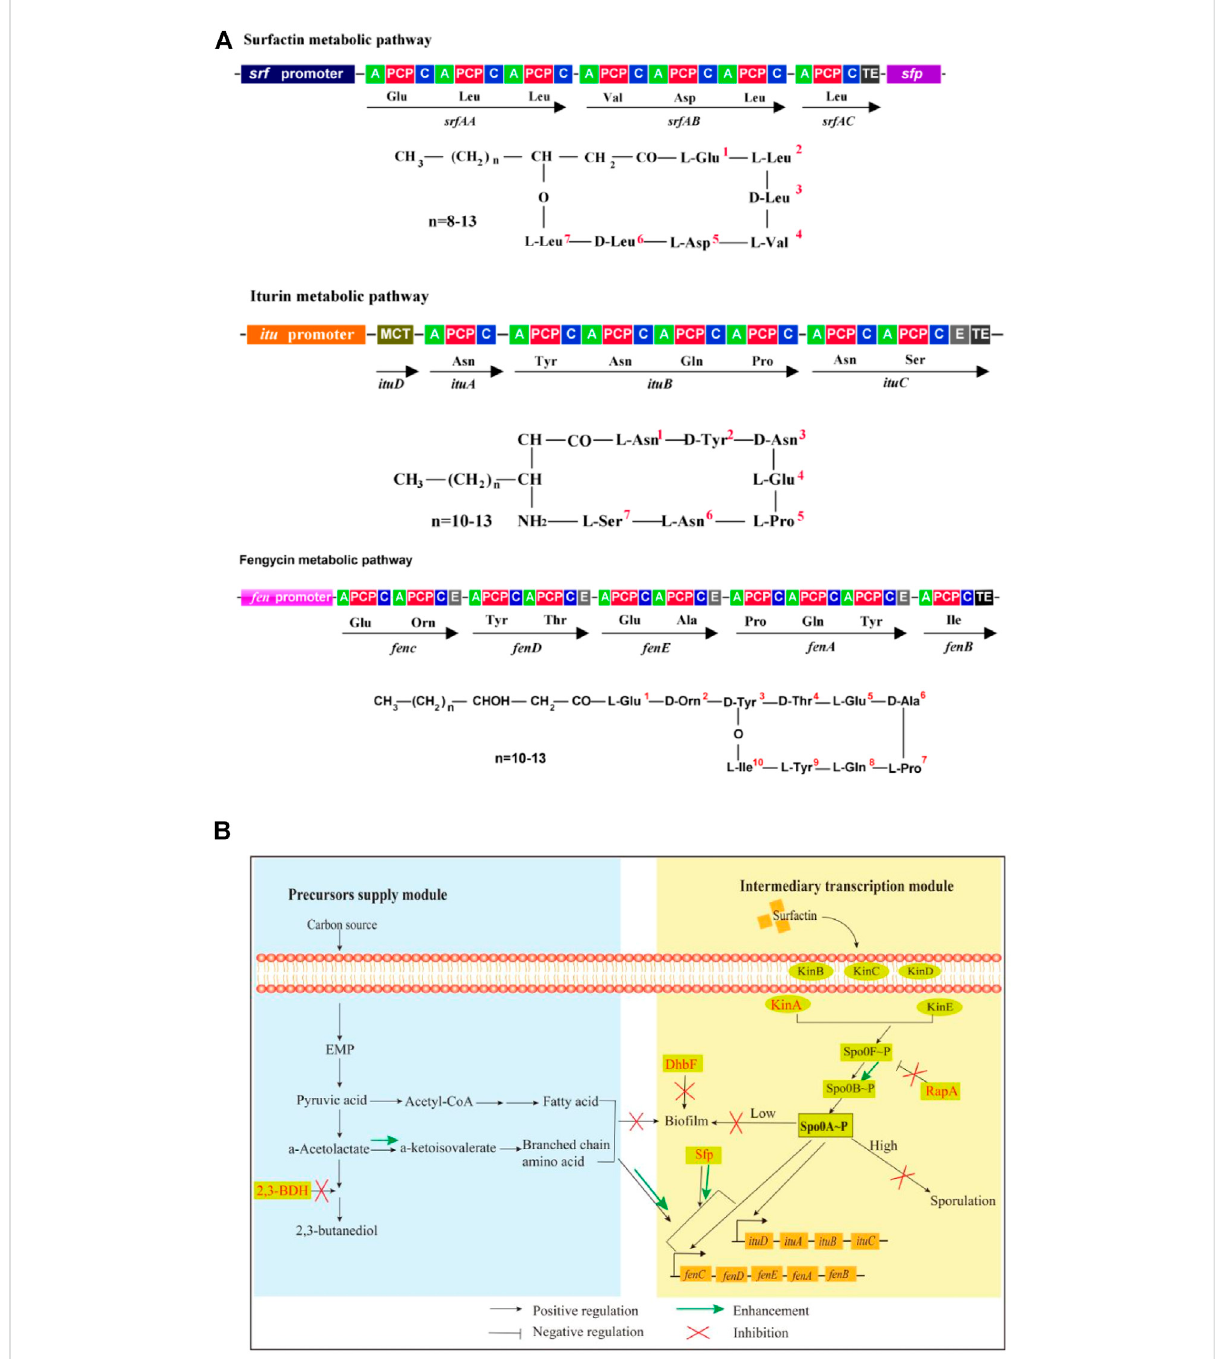
FIGURE 1 Molecular structures, biosynthesis pathways and regulator network of lipopeptides. (A) : Molecule structures and biosynthesis pathways of lipopeptides. In the fi gures, “ A ” means amino acid activating domain; “ PCP ” means peptidyl carrier protein; “ C ” means condensation domain; “ E ” meansepimerizationdomain; “ TE ” meansthioesterasedomain; “ MCT ” meansmonocarboxylatetransporter. (B) :Regulatorynetworkforbiosynthesis of iturin and fengycin. 2,3-BDH: 2,3-butanediol dehydrogenase; Kin A-E: histidine kinases; DhbF: biosynthesis of siderophore; Spo0A: global regulator; Spo0F and Spo0B: phosphate group transporter; RapA: aspartate phosphatase; Sfp:4-phosphopantetheinyl